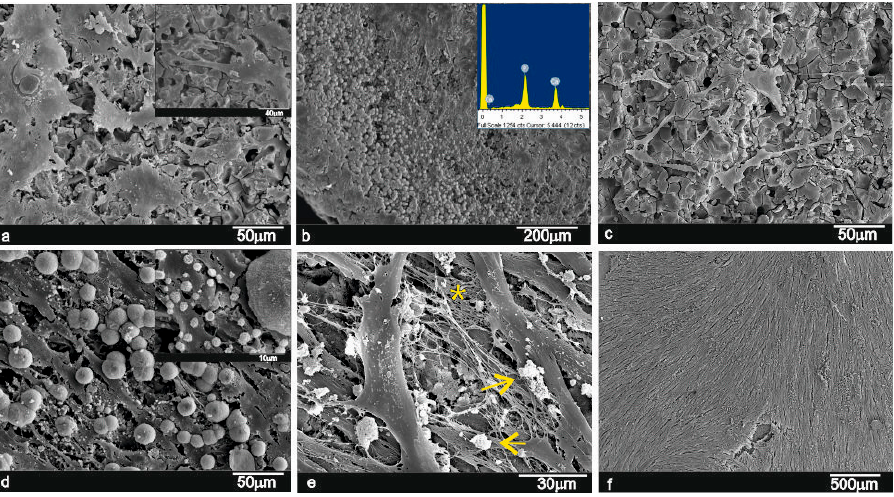
Figure 3. SEM images of the ahMSCs stem cells grown on ceramic surfaces after ( a , b ) 24 h; ( c , d ) 7; ( e ) 21 and ( f ) 28 days in GM.